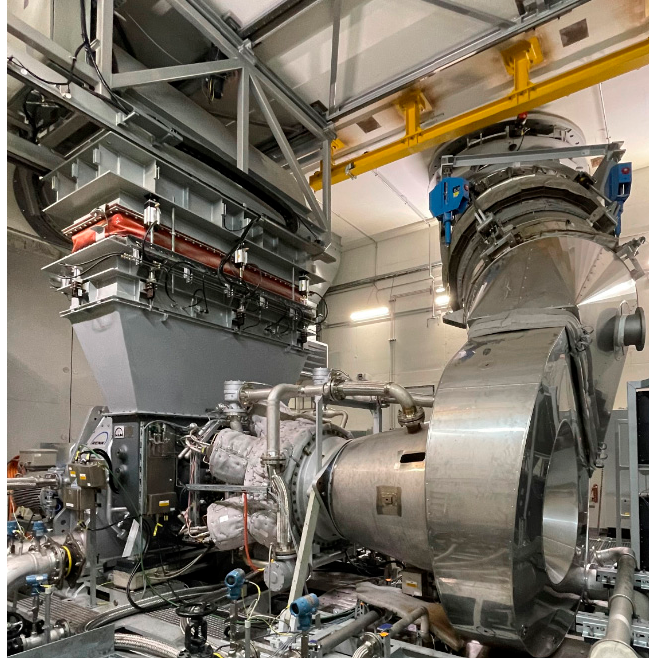
Figure 13. An MGT gas turbine installed at the MAN Oberhausen industrial gas turbine test facil- ity.